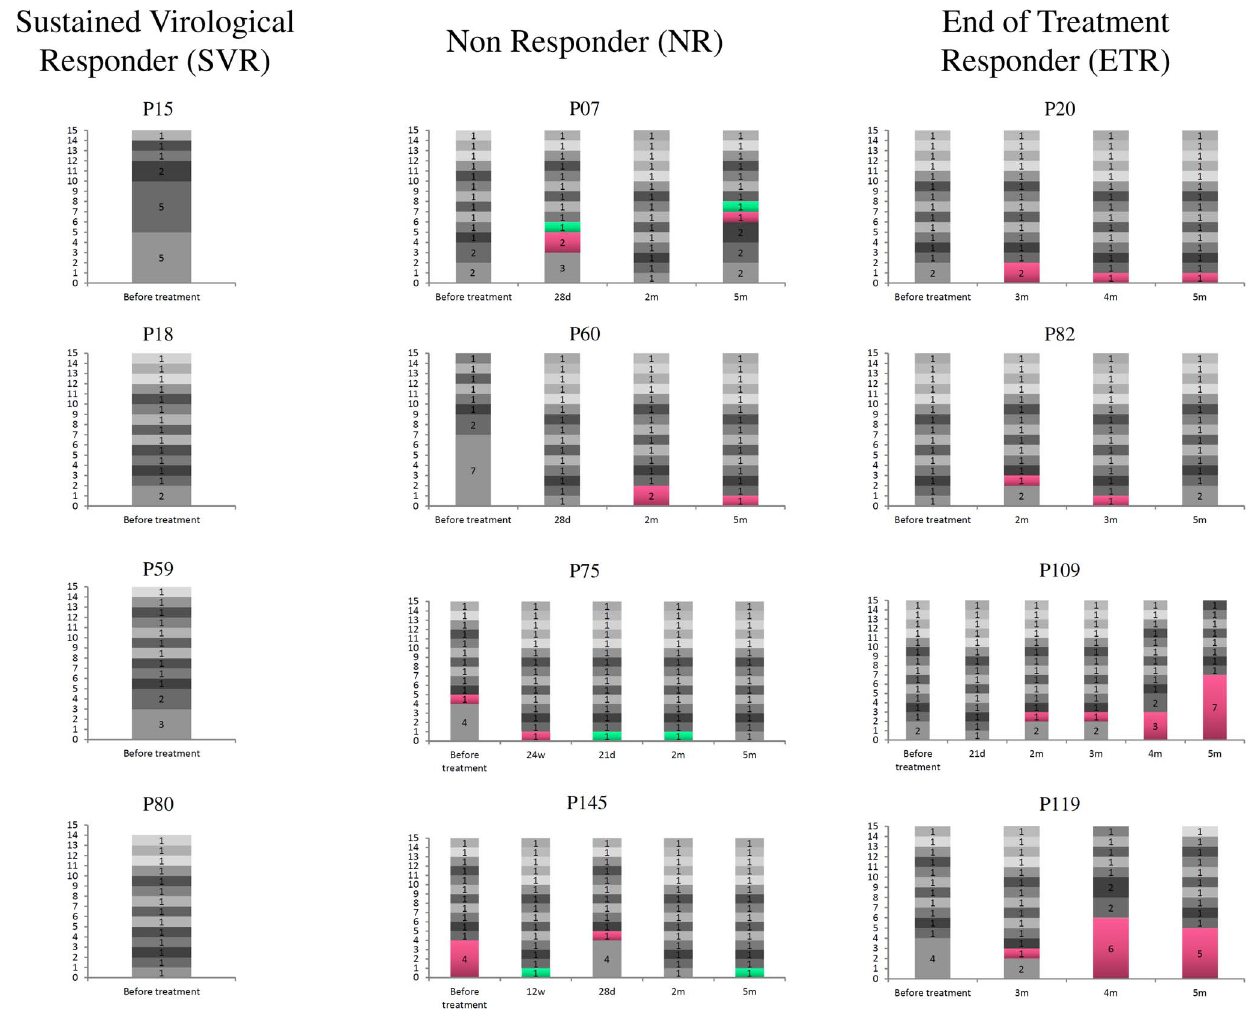
Figure 1. Eschematic representation of quasispecies. Left Y axis - graphic representation of different amino acid variants. Colored tiles represent the same variant. w-weeks; d-days; m-months. SVR data previously published in Bittar et al 2010 [20].